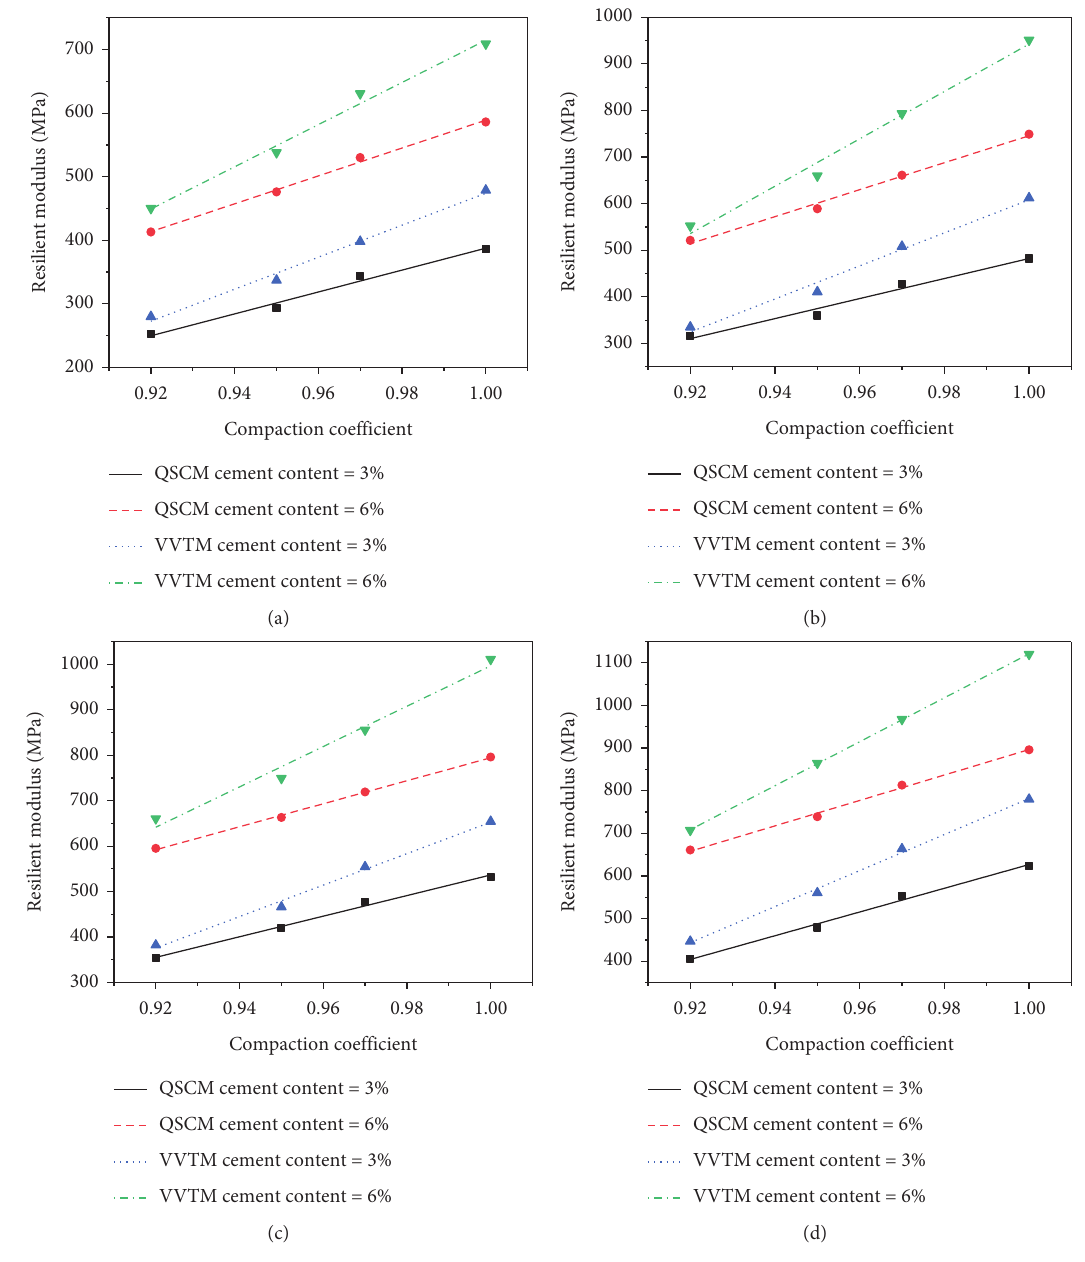
Figure 11: Influence of compaction coefficient on RM of CSL compacted using VVCM and QSCM. (a) 7d. (b) 14d. (c) 28d. (d)